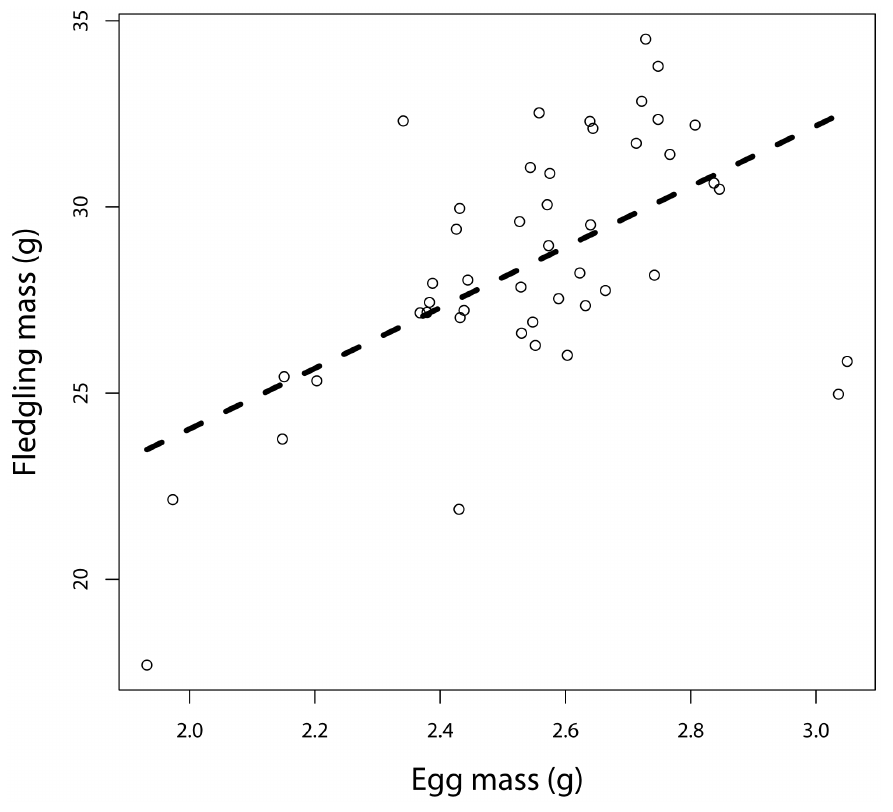
Figure 5. Fledging mass significantly increased in relation to egg mass.